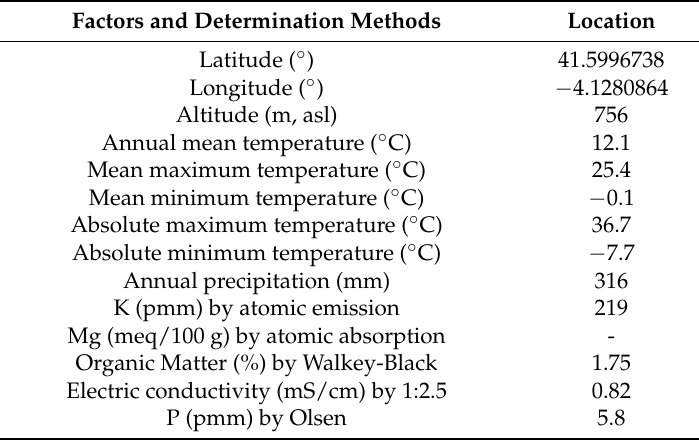
Table 1. Biophysical factors of the